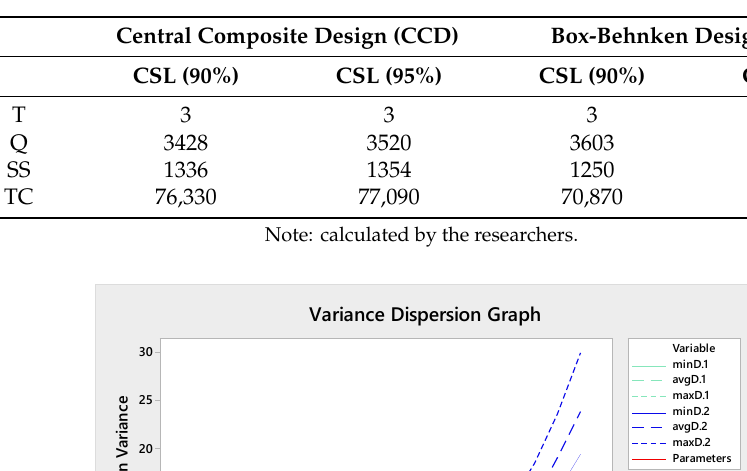
Table 7. The summary of the response optimizer results of CCD and BBD.